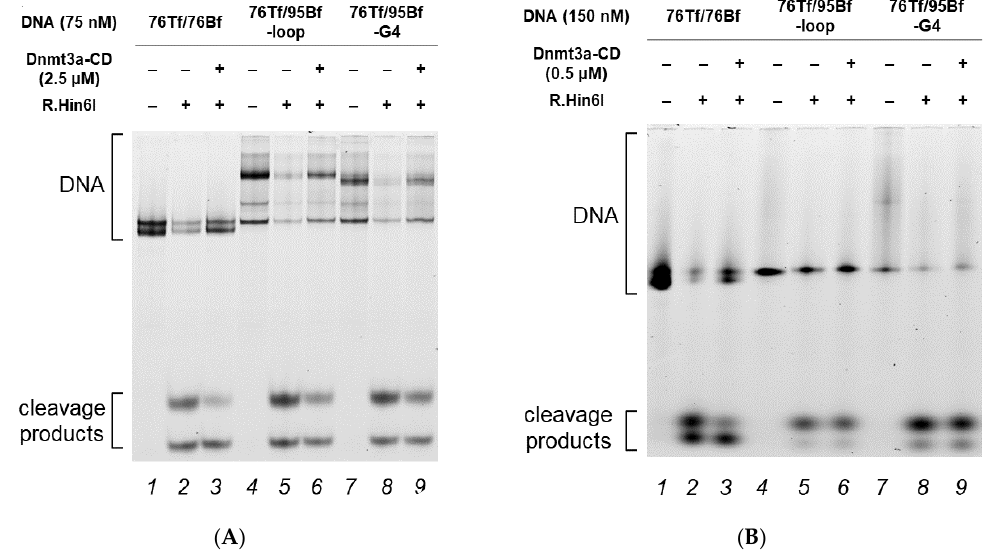
Figure 7. Effect of G4 structures on DNA methylation by Dnmt3a-CD. Cleavage of DNA duplexes by R.Hin6I after their methylation by Dnmt3a-CD. ( A ) 2.5 µM Dnmt3a-CD, 75 nM DNA, ( B ) 0.5 µM Dnmt3a-CD, 150 nM DNA. The reaction mixtures were analyzed in a 10% polyacrylamide gel containing 7 M urea. Table 2. Extent of methylation of DNA duplexes at different Dnmt3a-CD:DNA ratios. Extent of DNA Methylation *, % Dnmt3a-CD:DNA DNA Duplex